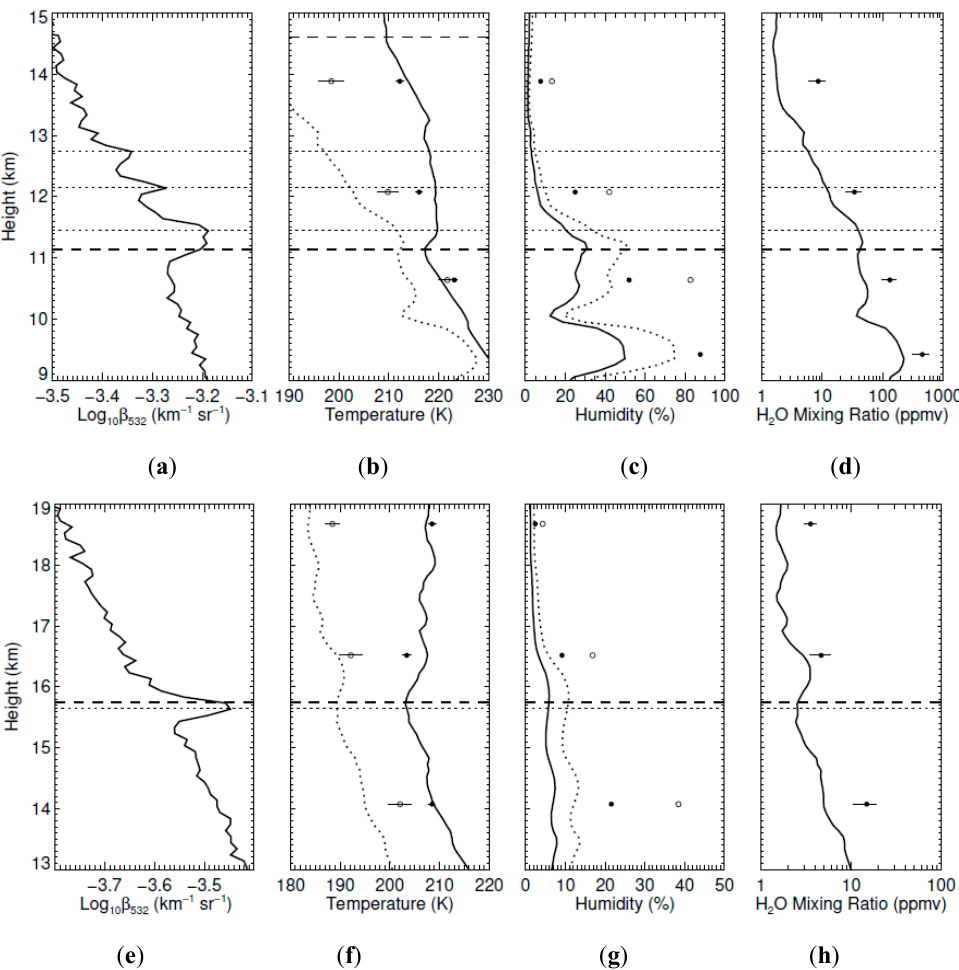
Figure 9. Comparisons of Buckland Park lidar, radiosonde and AIRS measurements for 30 April (panels ( a ) to ( d )) and May 03 (panels ( e ) to ( h )) 2015. Panels ( a ) and ( e ) show the mean total attenuated lidar backscatter. The thin dotted horizontal line marks the height of peak backscatter for identified layers. The thick dashed horizontal line marks the height of the first thermal tropopause obtained from the associated radiosonde measurements. Panels ( b ) and ( f ) show temperature (solid profile) and water-ice frost point temperature (dashed profile) from radiosonde measurements. Filled and open circles with 1 σ uncertainty limits show AIRS measurements of temperature and water-ice frost point temperature, respectively. Panels ( c ) and ( g ) show radiosonde profiles and AIRS measurements of humidity (solid profile and filled circles, respectively) and humidity over ice (dashed profile and open circles, respectively). Panels ( d ) and ( h ) show the water vapor mixing ratio from radiosonde and AIRS measurements (solid profile and filled circles with 1 σ uncertainty limits, respectively). The times of the radiosonde and AIRS measurements are noted in Table 2. In panel ( b ), the thin dashed horizontal line marks the second thermal tropopause. The vertical resolution is 200 m.